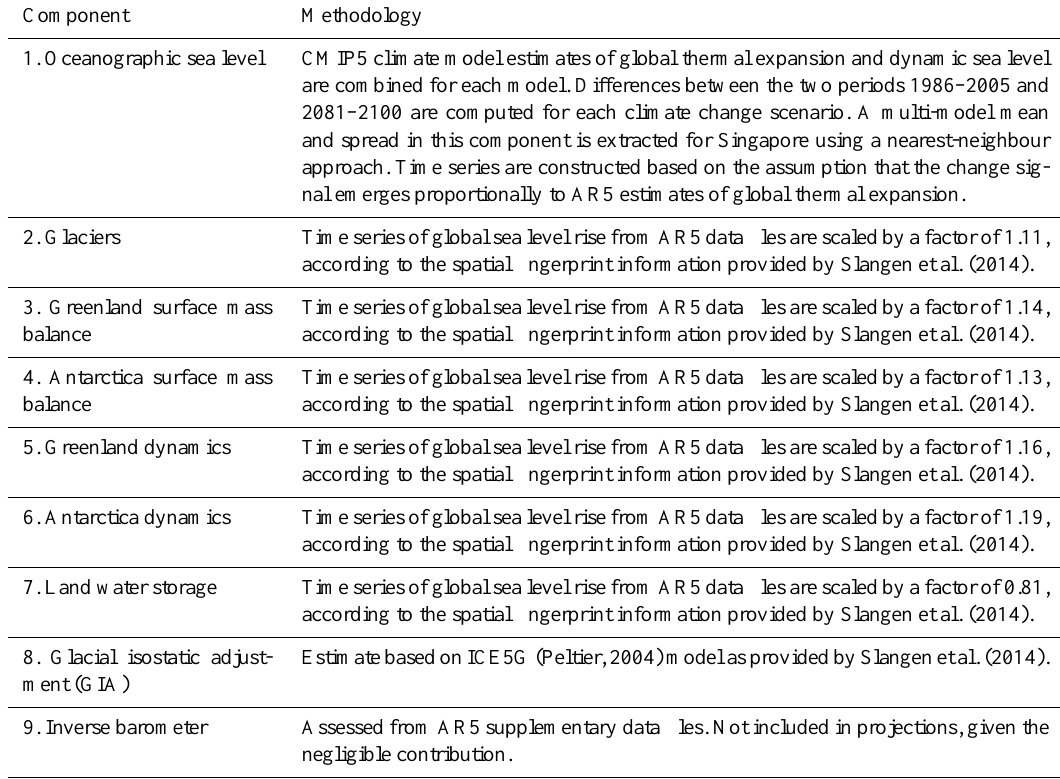
Table 1. Summary table of methodologies employed to estimate the different components of sea level rise at Singapore, including scaling factors used to convert global mean trends into local